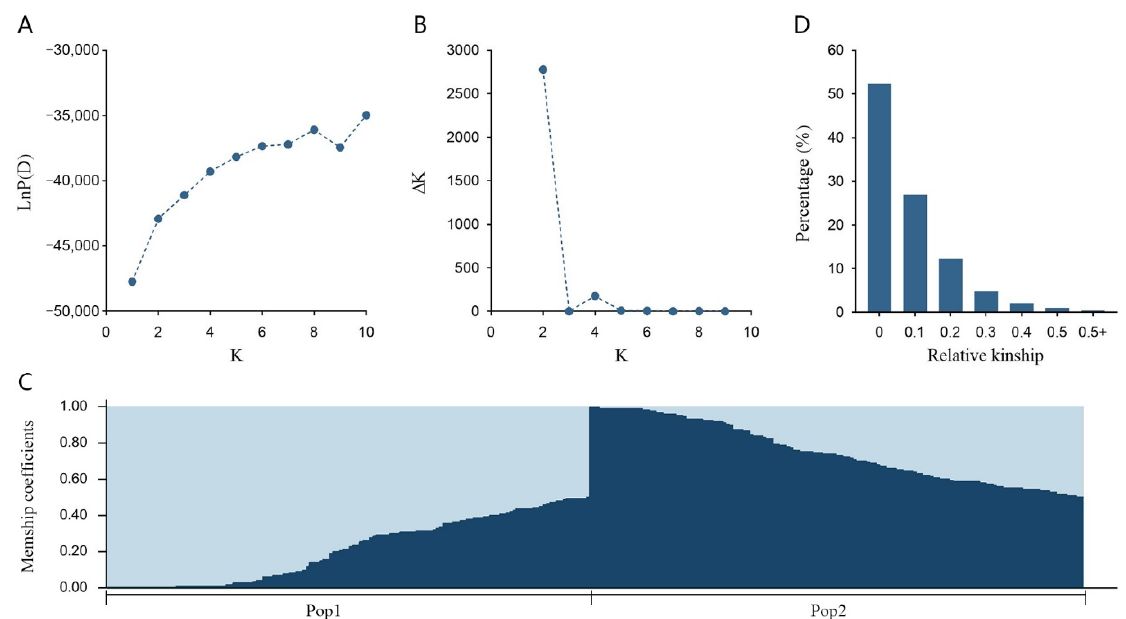
Figure 1. Population structure analysis and kinship coefficients distribution of 293 lotus accessions estimated by 93 genomic-SSR markers. ( A ) The most likely number of subpopulations (K) by LnP(D) analysis; ( B ) the most likely number of subpopulations (K) by ∆ K analysis; ( C ) the 293 lotus accessions were classified into two subpopulations, Pop1 (light blue zone) and Pop2 (dark blue zone); ( D ) the distribution of pair-wise kinship coefficients between 293 lotus accessions.